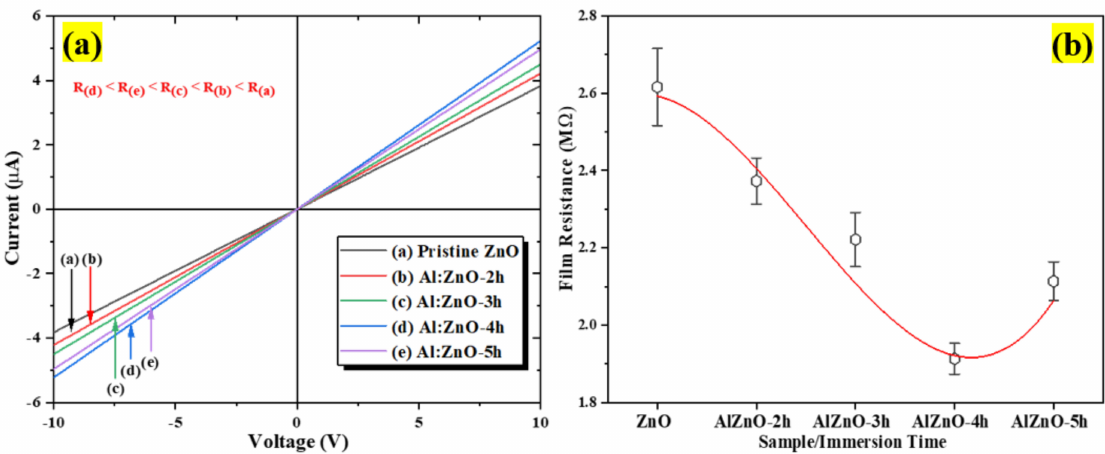
Figure 11. ( a ) Current-voltage (I–V) characteristics of the pristine ZnO and Al:ZnO sensing material at different immersion times and ( b ) sensing film resistance